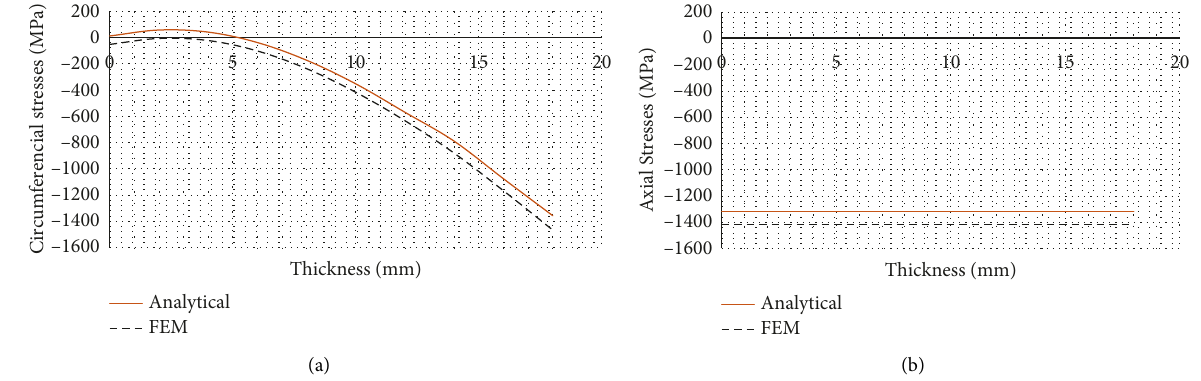
Figure 11: (a) Circumferential stresses and (b) axial stresses along disc